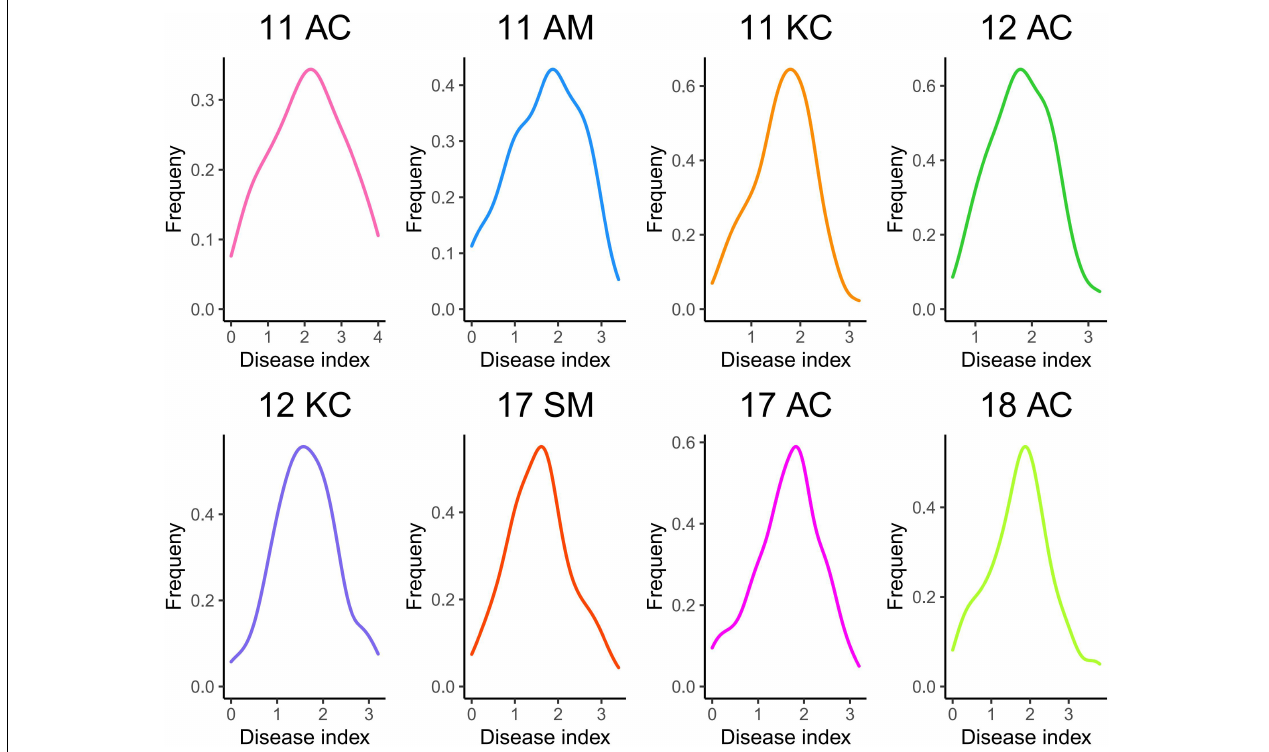
FIGURE 1 | Frequency distribution of disease severity rating in 110 RILs tested in different environments.